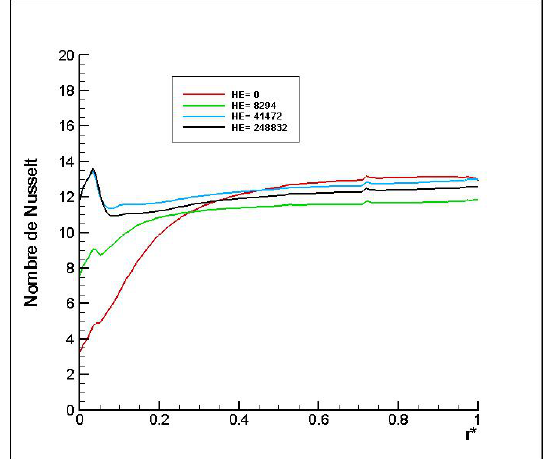
Fig. 10. Plasticity effect on the Nusselt number as a function of Bingham number.